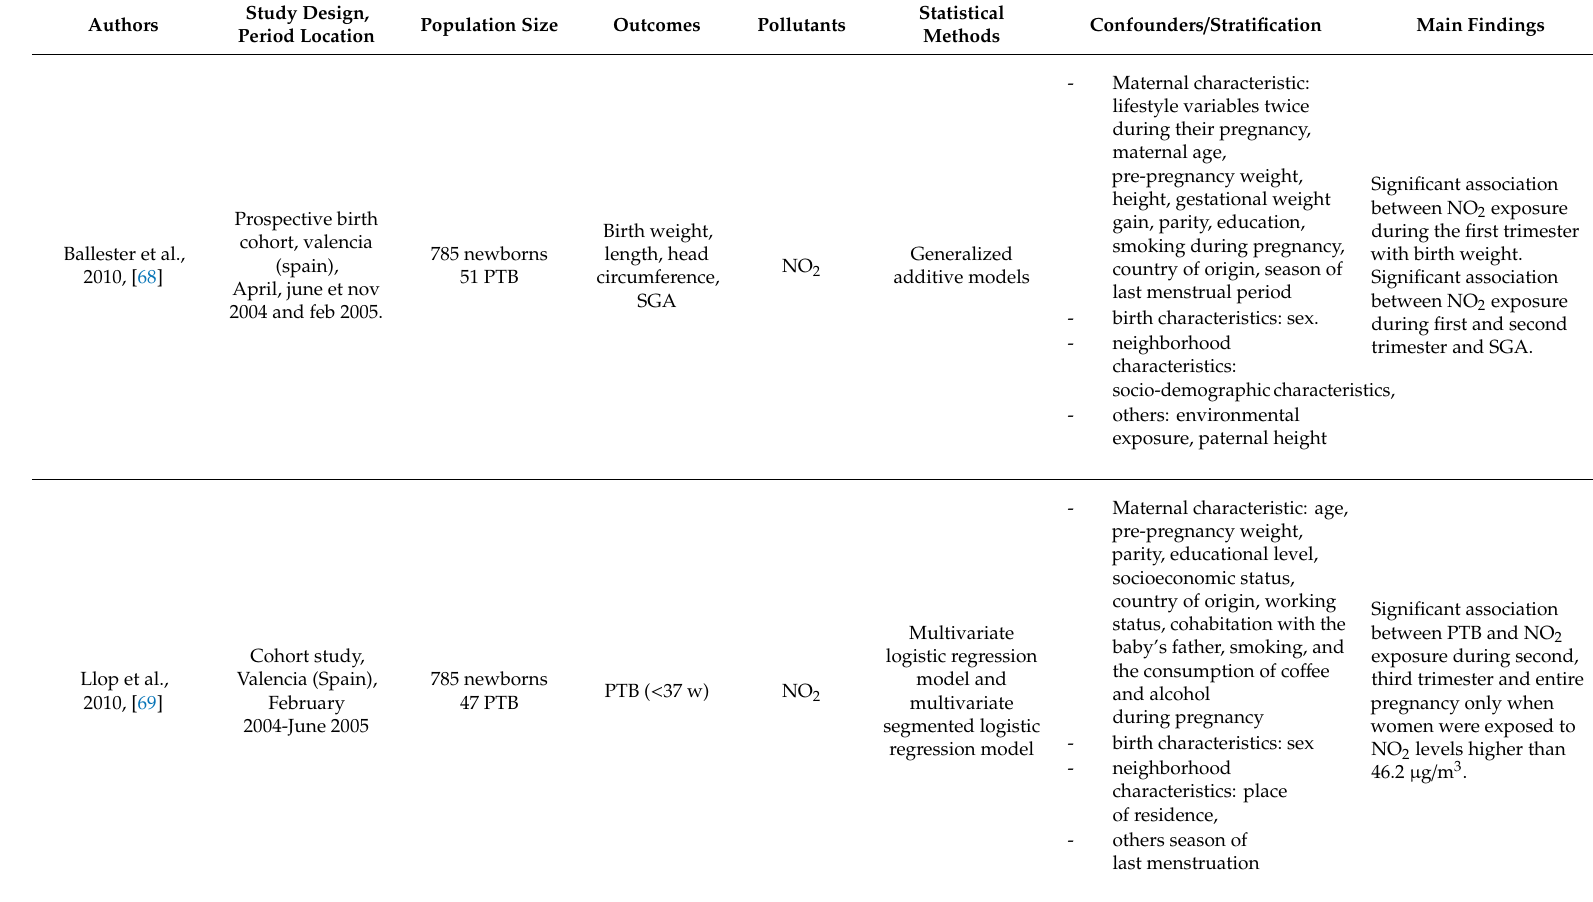
birth characteristics: sex neighborhood characteristics: